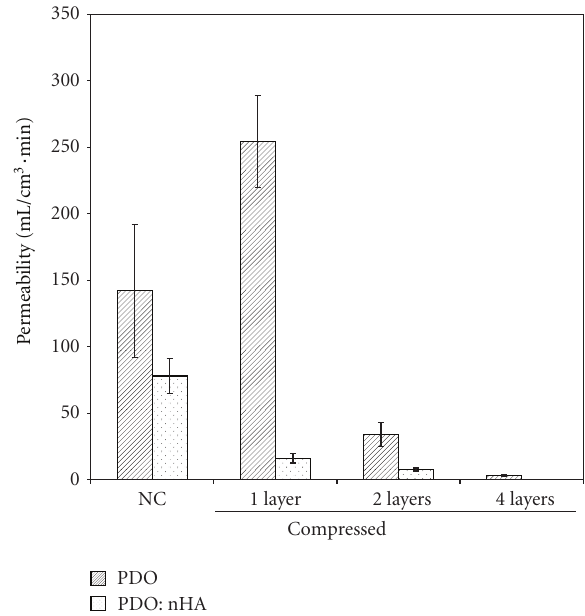
F 5: Effect on multilayered electrospun PDO and PDO:nHA scaffolds on permeability. Noncompressed (NC) scaffolds are single layers.